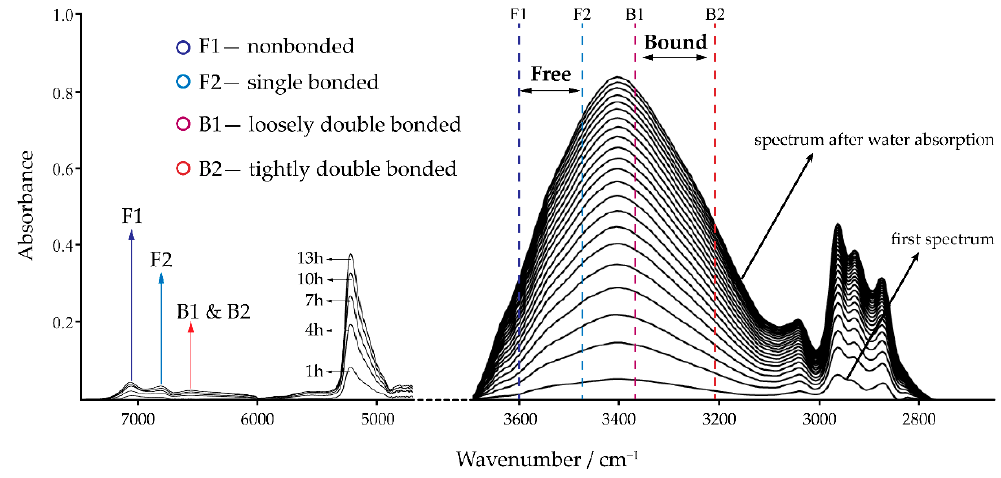
Figure 2. Water absorption peaks in near- and mid-range IR spectra; relative to associated bonding forces water molecules can affect the epoxy network structure. Copyright 2010. Reproduced from [89] with permission from Sage Publications Inc.